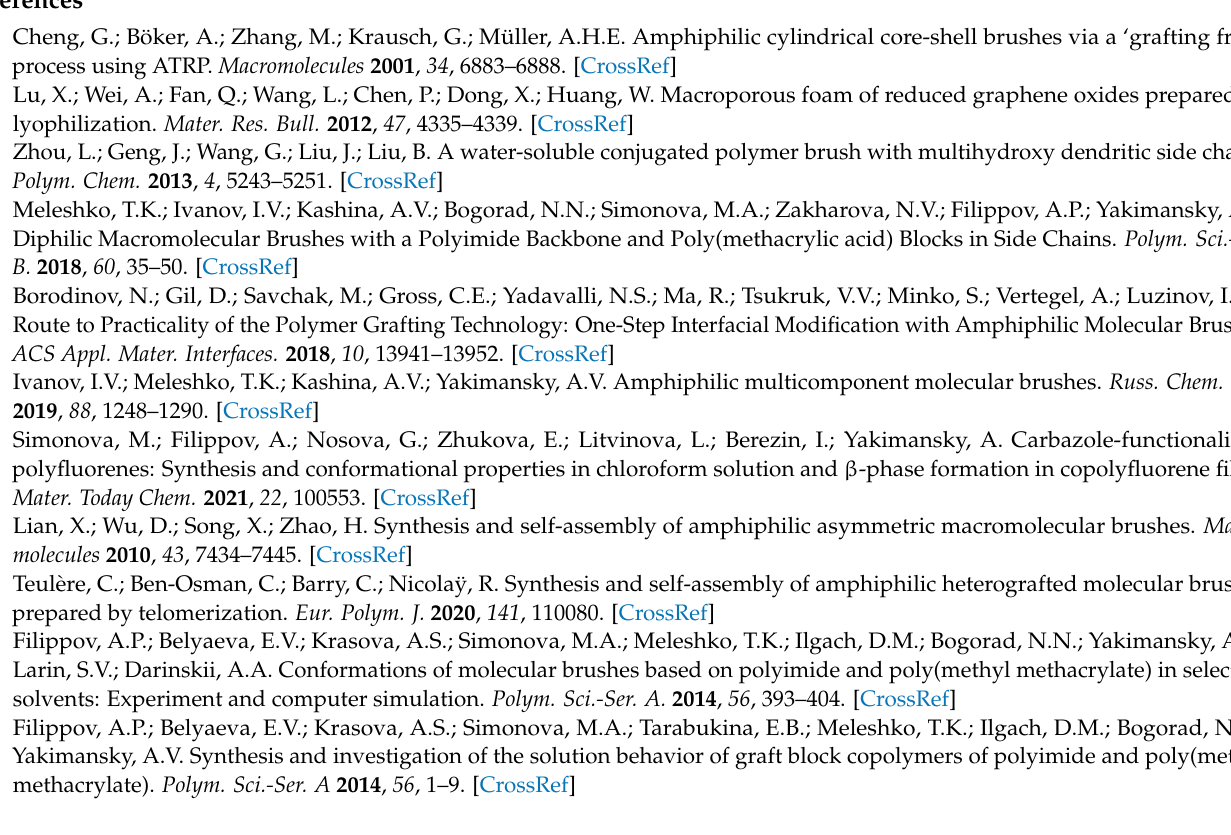
Figure S2: IR spectrum of APB2. Figure S3: Hydrodynamic radii distribution for MI solution at concentration c = 0.0044 g · cm − 3 in chloroform. I max is maximum intensity of scattered light at given concentration. Figure S4: Absorption and luminescence spectra of polymer brushes PB and APB. Figure S5: Zimm plot for APB3 in